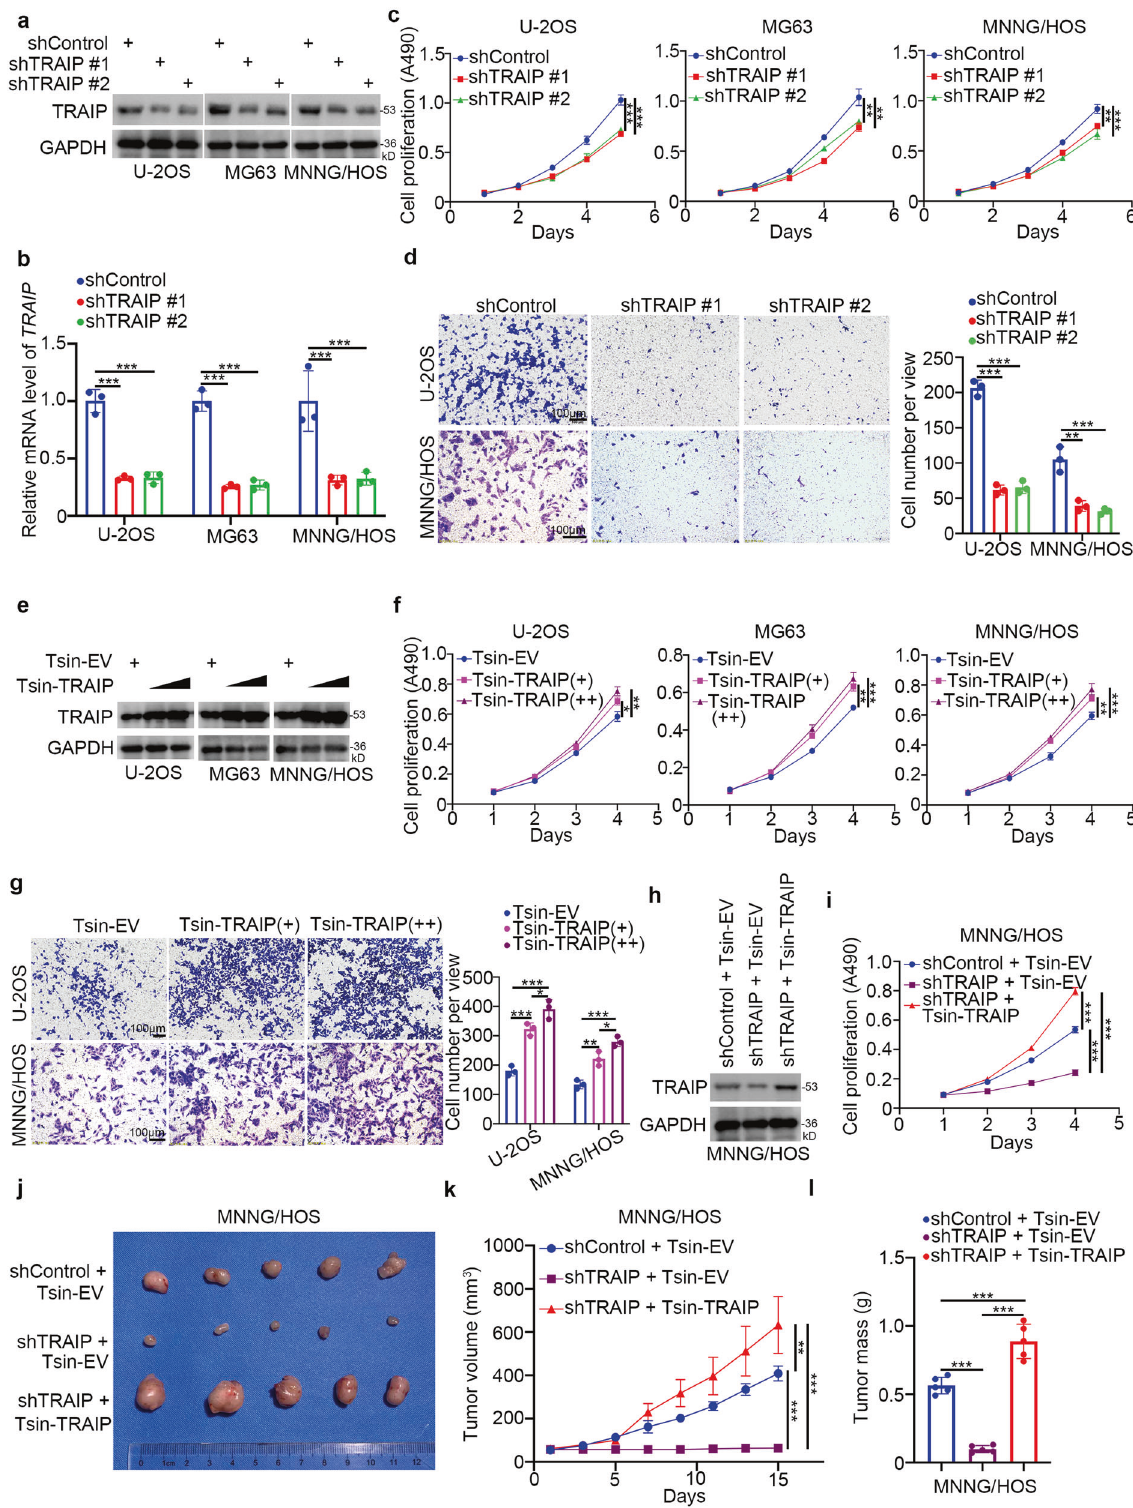
Fig. 4 TRAIP promotes osteosarcoma cell growth and invasion. a – d U-2OS, MG63, and MNNG/HOS cells were infected with indicated lentiviruses expressing shRNAs. After 72 h, cells were used for western blot analysis ( a ), qRT-PCR ( b ), MTS ( c ), and transwell assay ( d ). Data are shown as mean ± SD ( n = 3). ** P < 0.01; *** P < 0.001. e – g U-2OS, MG63, and MNNG / HOS cells were infected with the indicated lentiviruses expressing Tsin plasmids. After 72 h, cells were used for western blot analysis ( e ), MTS assay ( f ), and transwell assay ( g ). Data are shown as mean ± SD ( n = 3). * P < 0.05; ** P < 0.01; *** P < 0.001. h , i MNNG/HOS cells were infected with the indicated lent i viruses expressing shRNAs and Tsin plasmids. After 72 h of puromycine selection, cells were used for western blot analysis ( h ), MTS assay ( i ), and xenograft growth assay in nude mice. j – l Representative tumor images ( j ), tumor growth curves ( k ), and tumor weights ( l ) are shown. MTS data are shown as mean ± SD ( n = 3). *** P < 0.001. Xenograft data are shown as mean ± SD ( n = 5). ** P < 0.01; *** P < 0.001. Cell Death and Disease (2021)